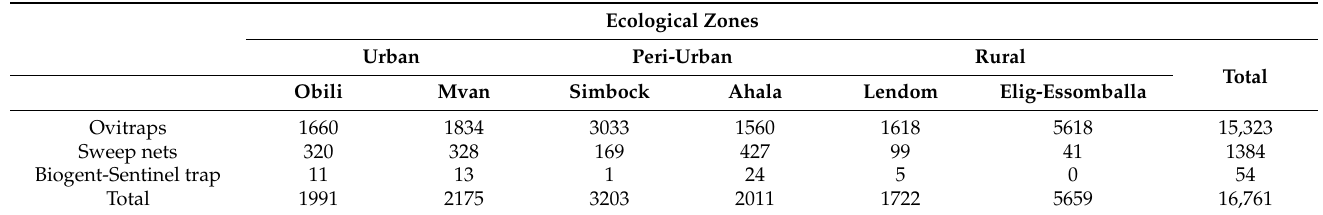
Table 1. Abundance of mosquitoes according to sampling techniques and ecological zone.